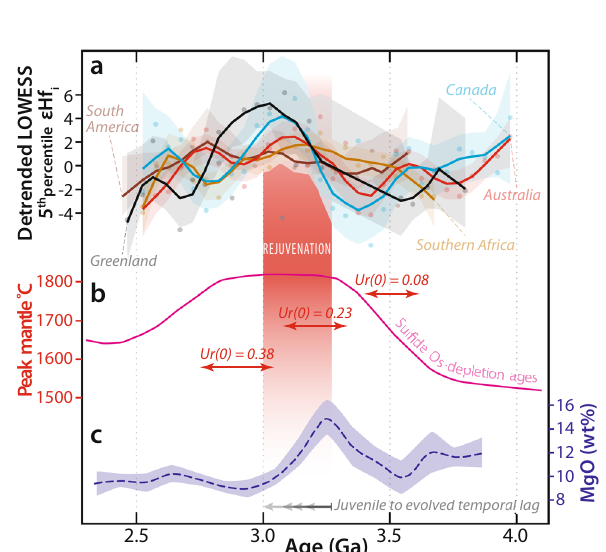
Fig. 6 Global Hf evolution compared to geochemical proxies of mantle condition. a Global compilation 28 of detrended LOWESS (locally weighted scatterplot smoothing) fi ts to the 5th percentile ε Hf i for the different Archean cratons in Fig. 5. Fits include faded 95% con fi dence band. b Sul fi de Os- depletion model age probability density plot from Pearson et al. 32 and peak mantle temperatures for different Urey ratios (Ur) shown as red arrows 36 . c Global mean MgO in basalts from El Dien et al. 30 , shown with two standard error of the mean uncertainties determined after bootstrap resampling. The concomitant increase in the 5th percentile ε Hf i and geochemical parameters of mantle temperature indicate a global crustal rejuvenation event at c. 3.2 – 3.0 Ga. Source data information is provided in Supplementary Data 5.